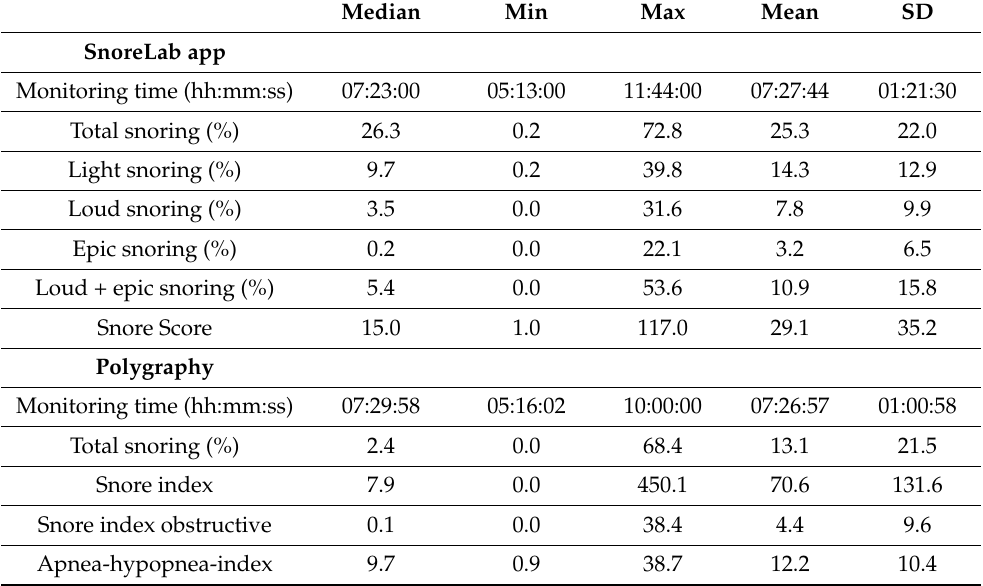
Table 2. Median, minimal and maximal values as well as means and standard deviations of measure- ments derived by the SnoreLab app and polygraphy.